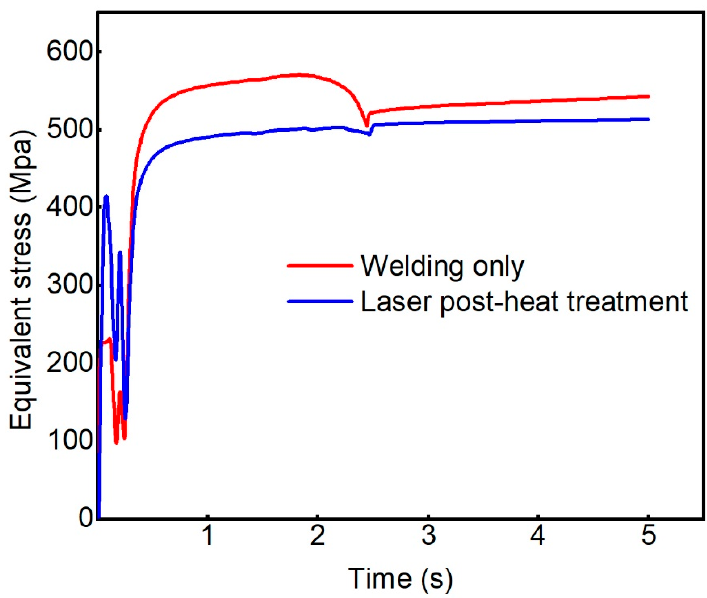
Figure 14. Residual equivalent stress history diagram of weld zone in different processes.